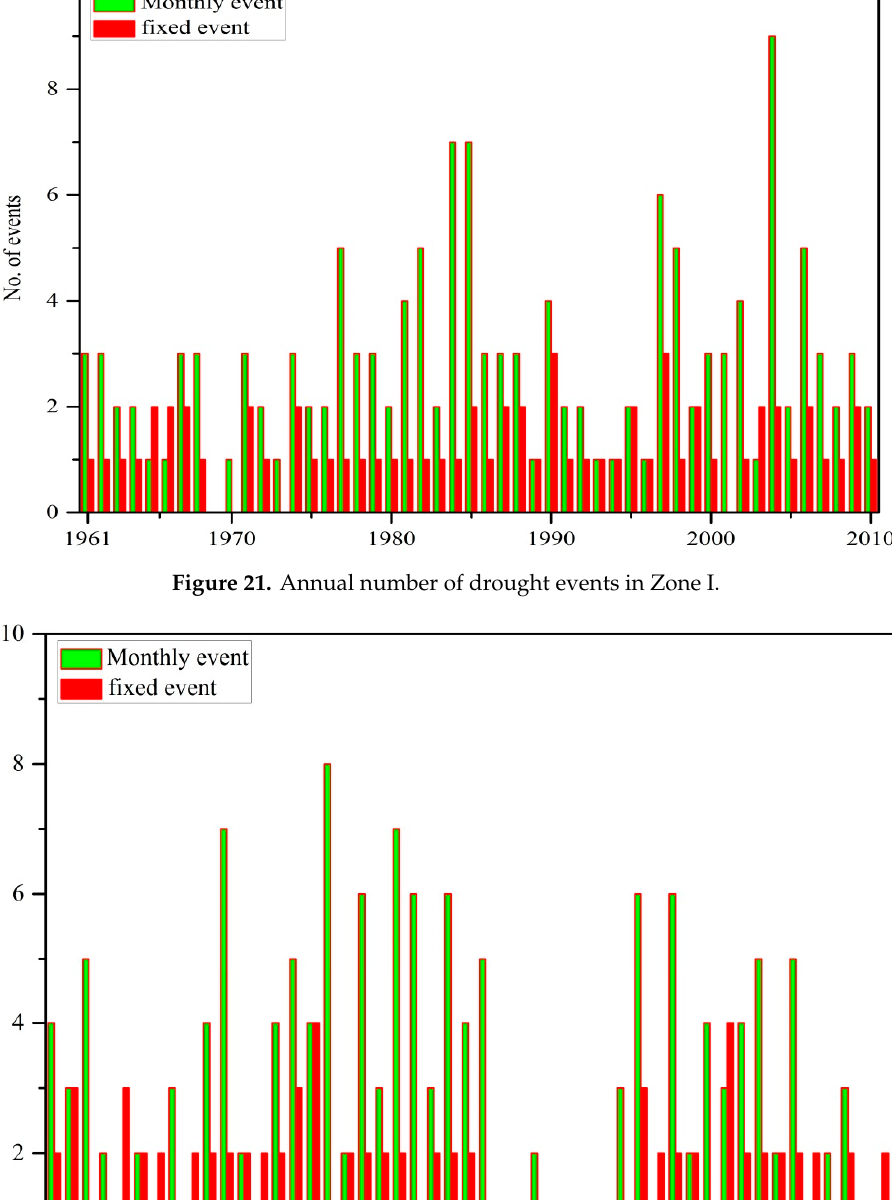
Figure 20. Fixed and monthly threshold levels for both zones. ( a ) Fixed ( b ) monthly threshold levels